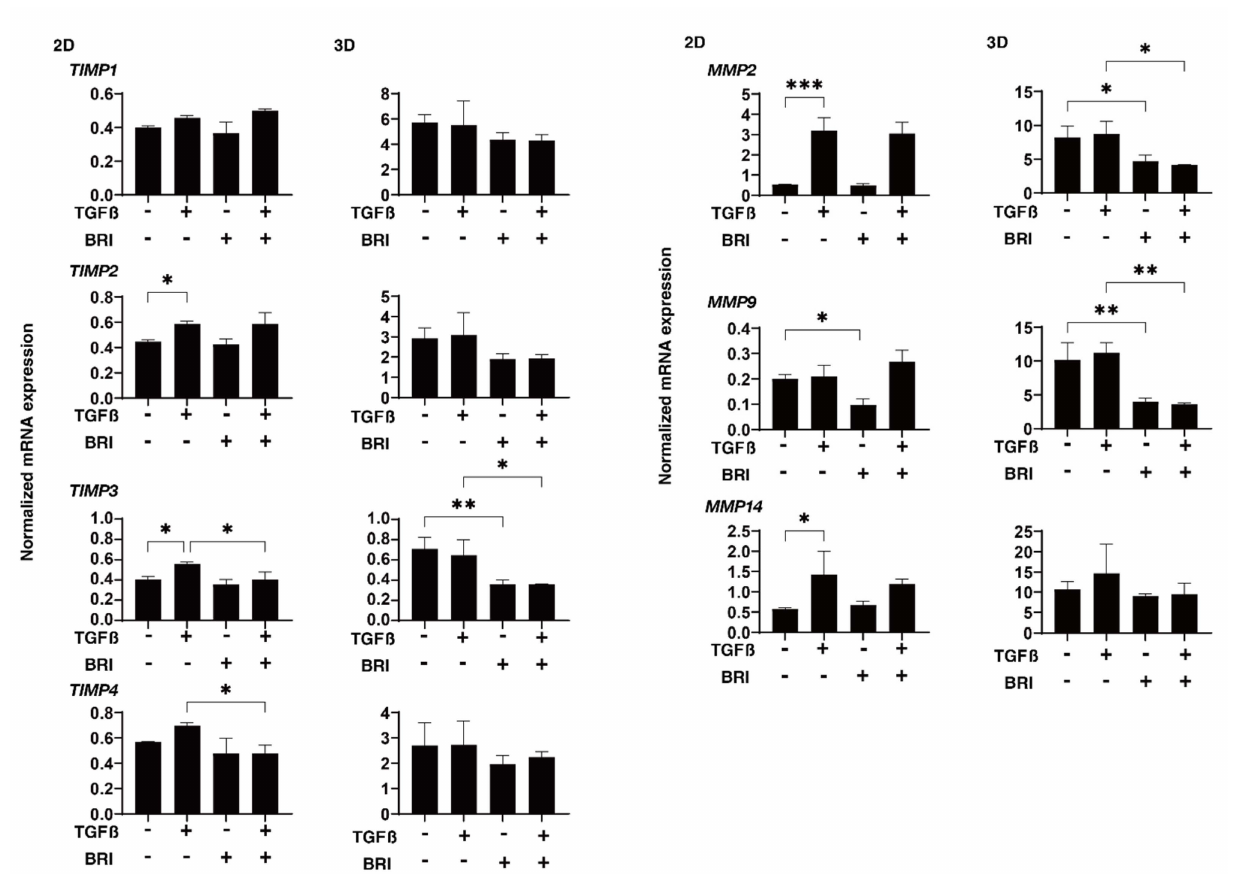
Figure 7. Effects of brimonidine (BRI) on the gene expression of TIMPs and MMPs in TGF- β 2-treated 2D and 3D HTM cells. The 2D- and 3D-cultured HTM on day 6 were untreated (NT) or treated with 5 ng/mL TGF- β 2 (TGF β ) in the presence or absence of 10 µ M brimonidine (BRI) and were applied to a qPCR analysis to evaluate the gene expression of TIMP1-4 and MMP 2 , 9 , and 14 . All experiments were conducted in triplicate using freshly prepared samples (2D cells; n = 5 and 3D spheroids; n = 15–20) in each experimental condition. “+” is reagents addition. “ − ” is reagents non-addition. Regarding the data, the mean ± standard error of the mean (SEM) are shown. * p < 0.05, ** p < 0.01, *** p < 0.005; ANOVA followed by a Tukey’s multiple comparison